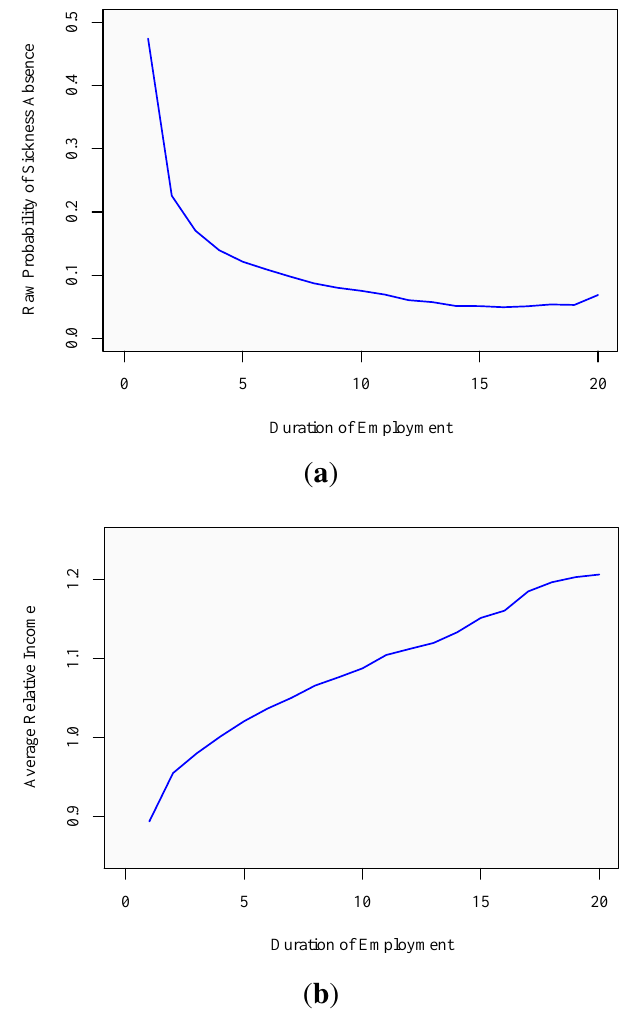
Figure 2. The effect of duration. ( a ) Duration and sickness absence; ( b ) duration and relative